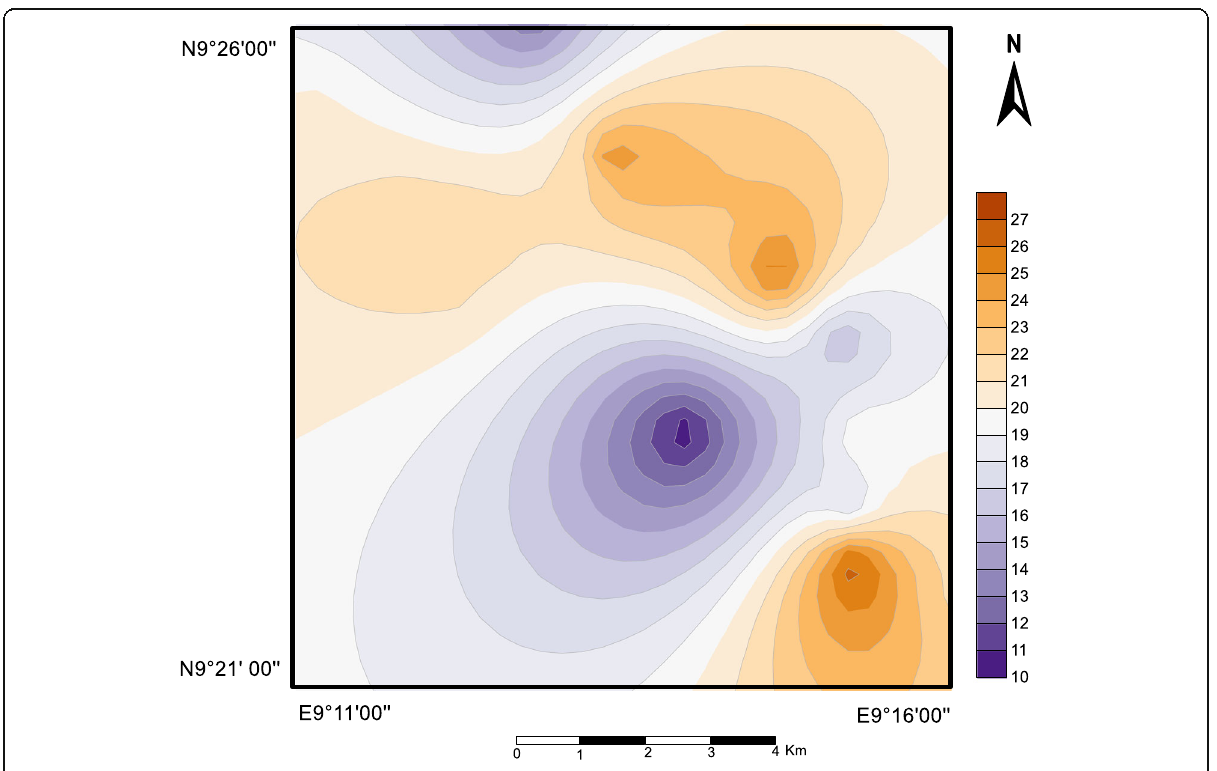
Fig. 8 Characterization of Plasticity Index in the